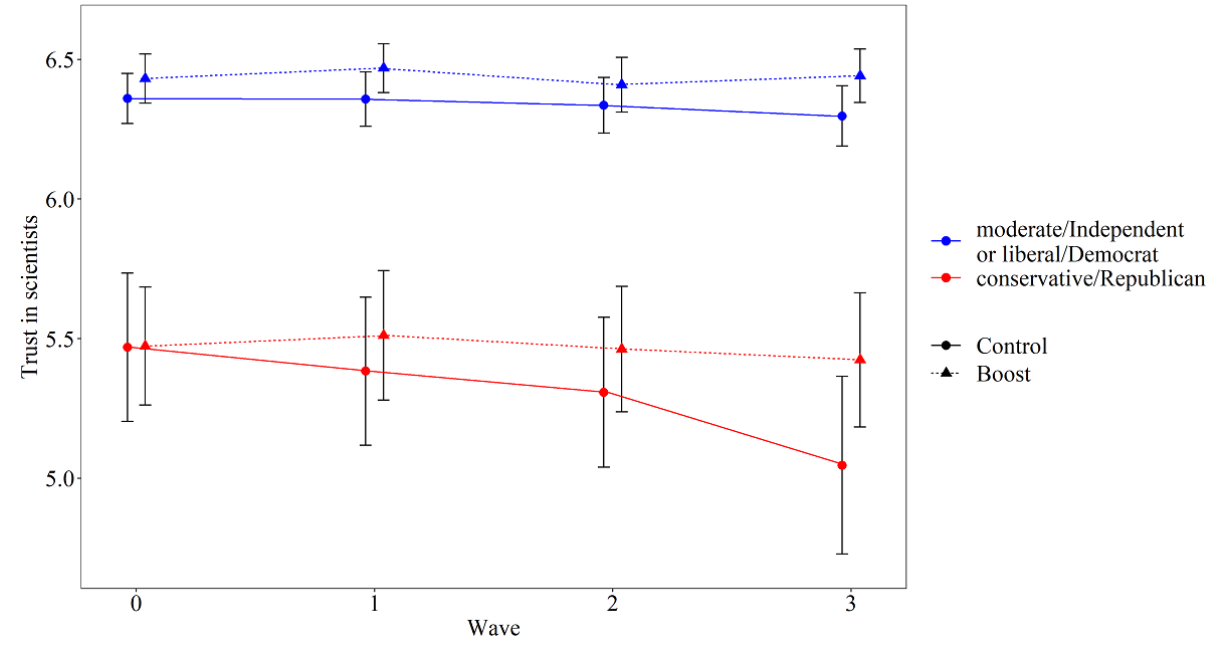
Figure 6. Trust in scientists as a source of information about the coronavirus per condition and political orientation (dichotomized for plotting) over time. Error bars indicate 95% CI focusing on the comparison between experimental conditions, not adjusted for within-subject variability. Trust in scientists was measured with responses to the statement “I trust scientists as a source of information about the coronavirus.” Participants responded on a 7-point scale ranging from 1 (strongly disagree) to 7 (strongly